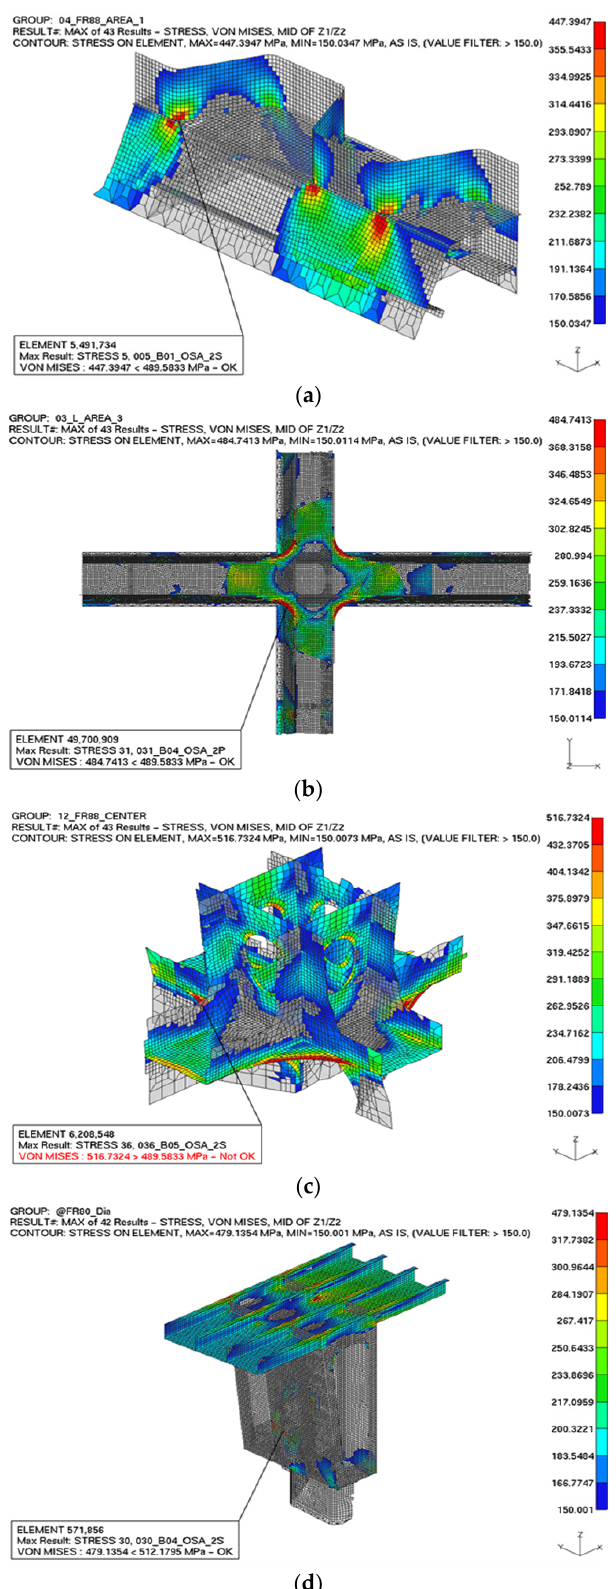
Figure 14. Maximum von Mises stress results with varying critical locations using a very fine meshing model: ( a ) lower stool–corrugated bulkhead connection; ( b ) center bulkhead–bracket connection; ( c ) upper stool–bracket connection; ( d ) upper stool–main deck